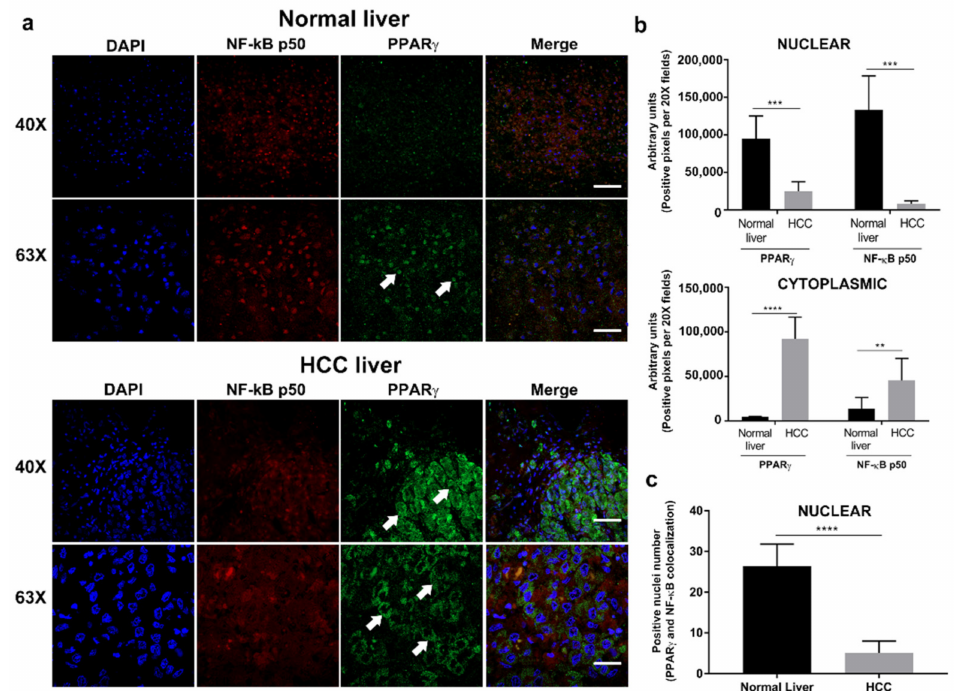
Figure 1. PPAR γ and NF-kB p50 differential expression in human tissues. ( a ) Double IF of PPAR